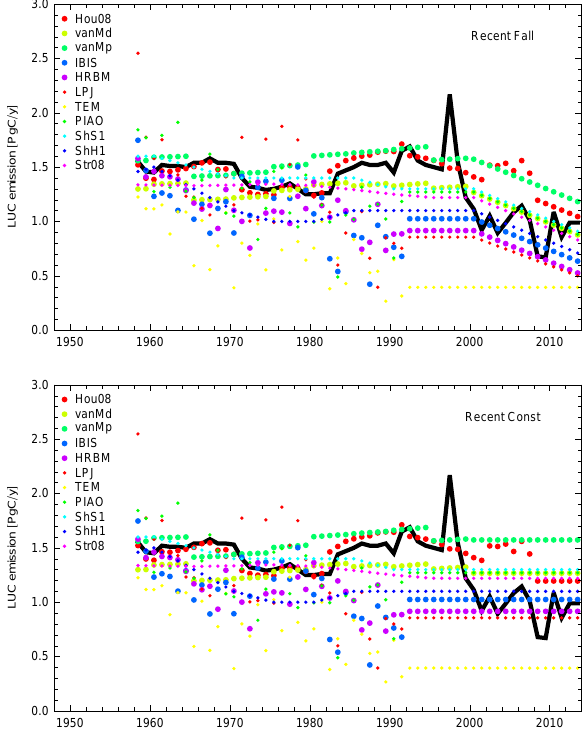
Figure D3. Alternative trajectories for CO 2 emissions from net land use change ( f LUC ): (black) primary data; (coloured dots) alternative trajectories described in Table D1. Upper and lower panels show “Recent Fall” and “Recent Const” extrapolations,